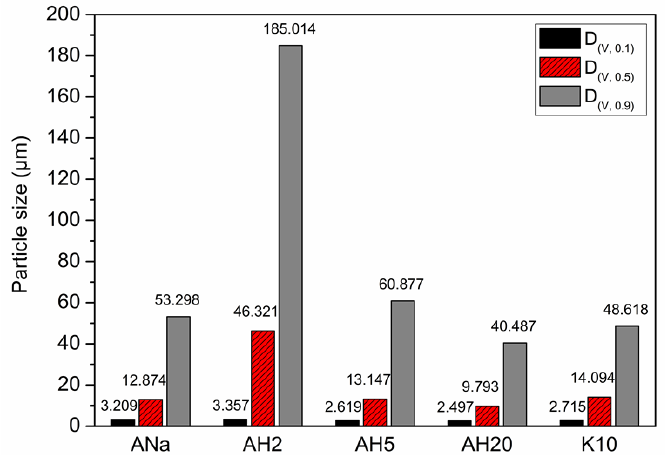
Figure 3. Particle size analysis of the clay minerals through the parameters D (V, 0.5) , D (V, 0.1) and D (V, 0.9) .